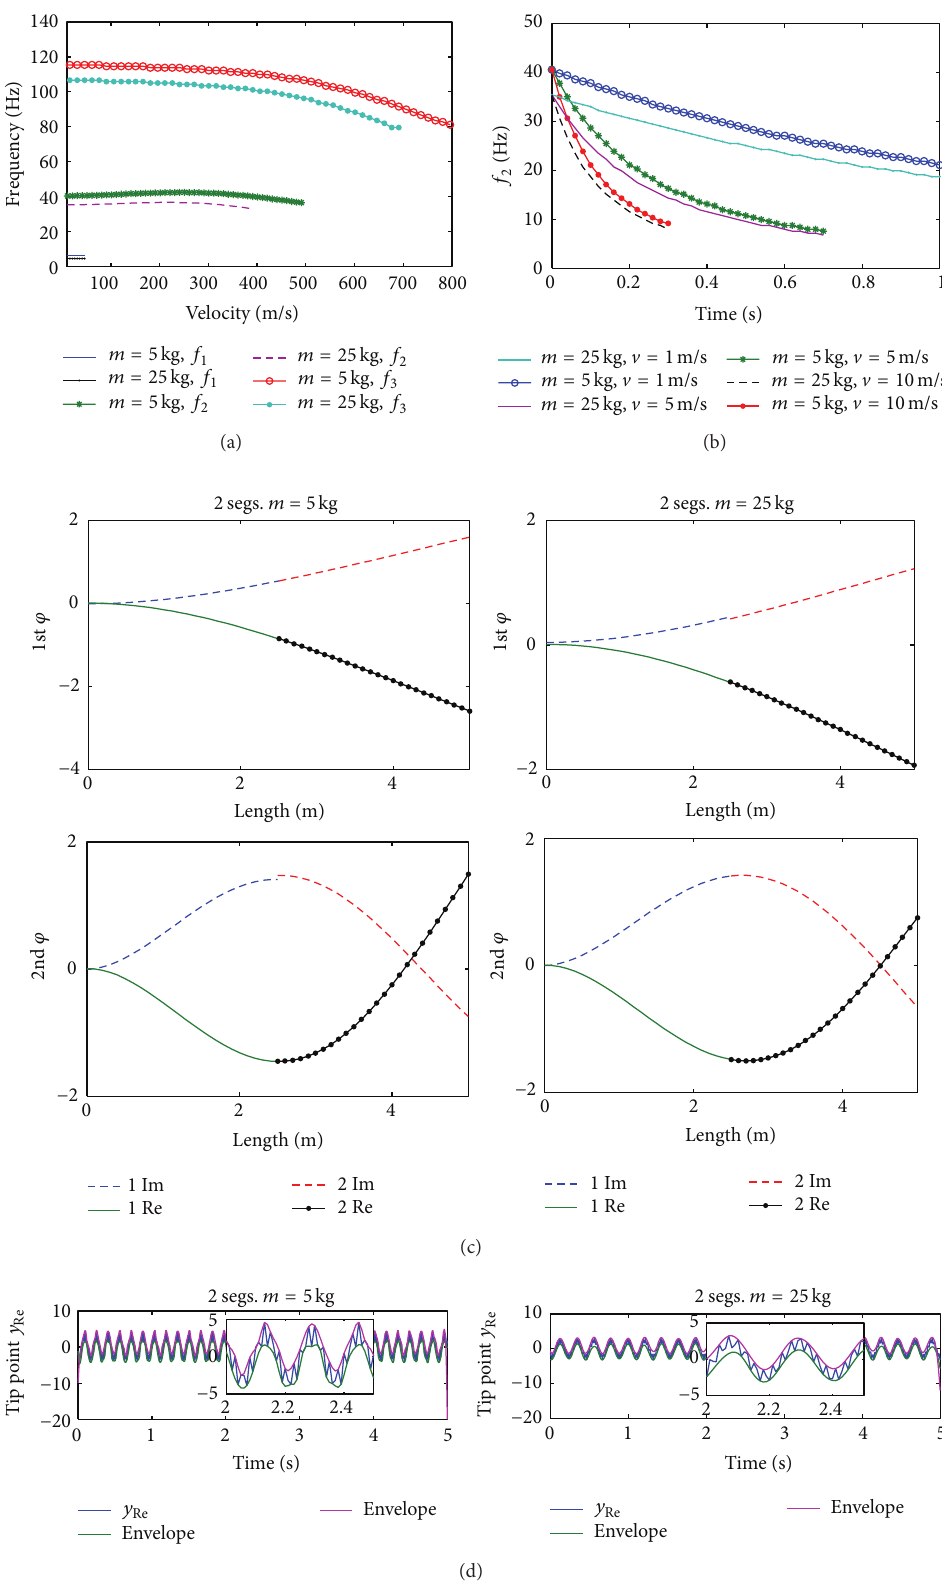
Figure 3: (a) Natural frequency changes with velocity. (b) Natural frequency changes with time. (c) V = 10 m/s the modal function changes. (d) V = 10 m/s, the tip displacement 𝑦 Re